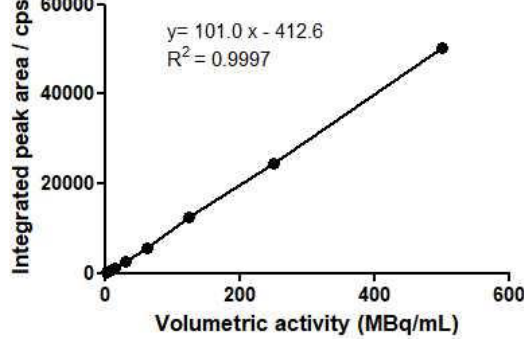
Figure 4. Linearity in TLC method.